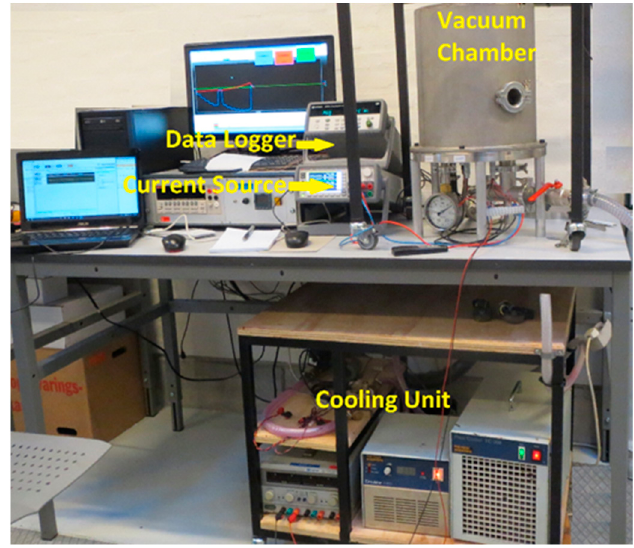
Figure 5. Experimental setup to study the transient behavior of the thermoelectric generator.